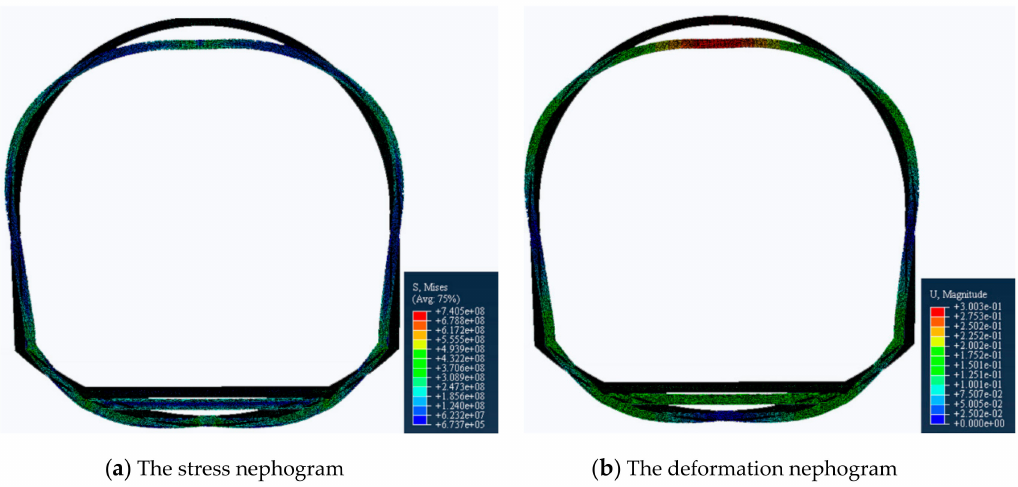
Figure 14. The stress nephogram and the deformation nephogram of FB set I.